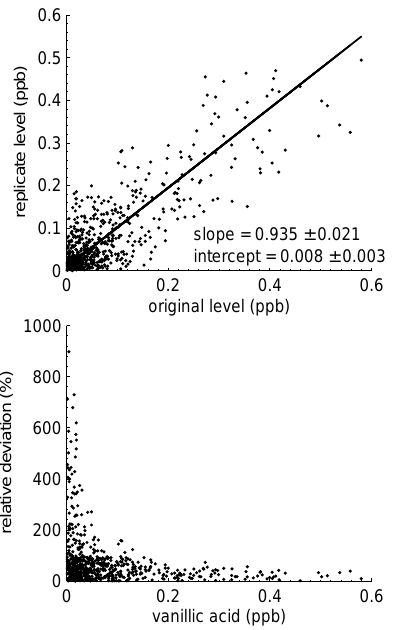
Figure 4. Measured vanillic acid level (ppb) compared to replicate vanillic acid level (ppb) (top). The line is the least-squares fit ac- counting for both the original and replicate measurements. Vanil- lic acid level (ppb) compared to the relative standard deviation (%) (bottom).